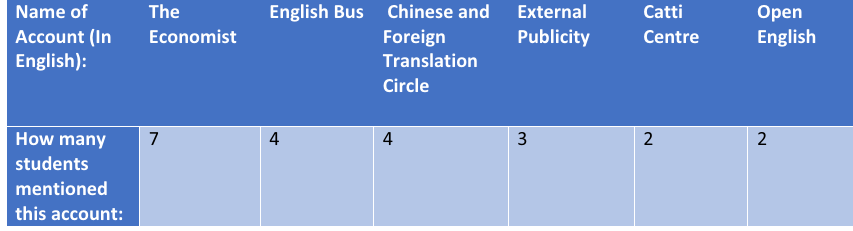
The star function